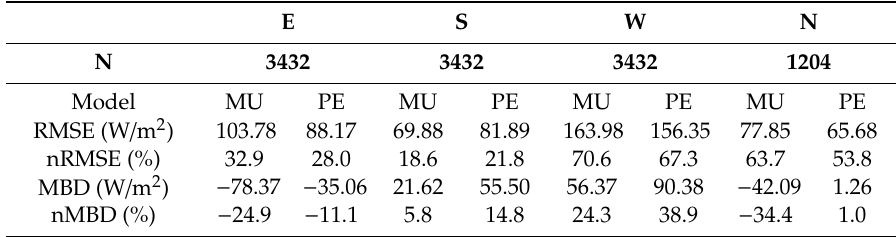
Table 5. Results of the comparison of calculated and measured irradiance data at four different orientations (E, S, W, N) for hourly data collected by NREL laboratories in 2018.